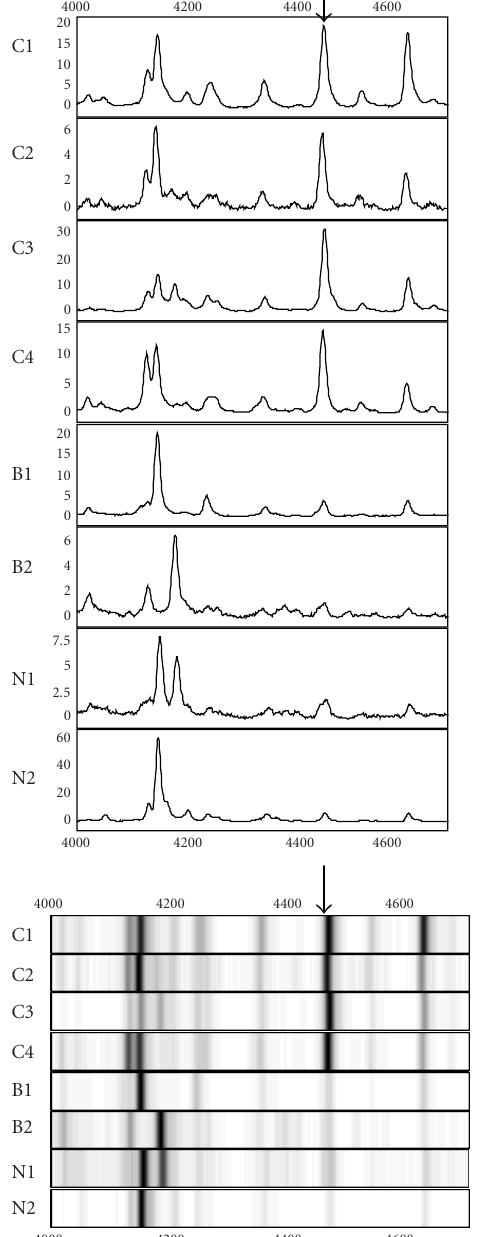
Figure 6. Spectra (top) and grey-scale or gel views (bottom) of the peaks (arrows) forming the splitting rules. The protein peak was detected on the SAX surface. The peak appears to be up- regulated in the cancer (C1–C4) compared to the begin (B1-B2) and normal (N1-N2) groups.